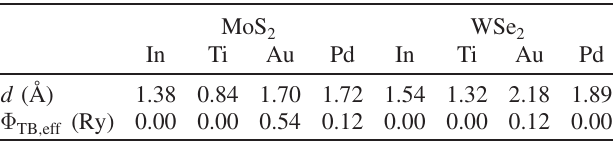
TABLE I. Evaluation of tunnel barriers at metal-mTMD edge-contact interfaces.